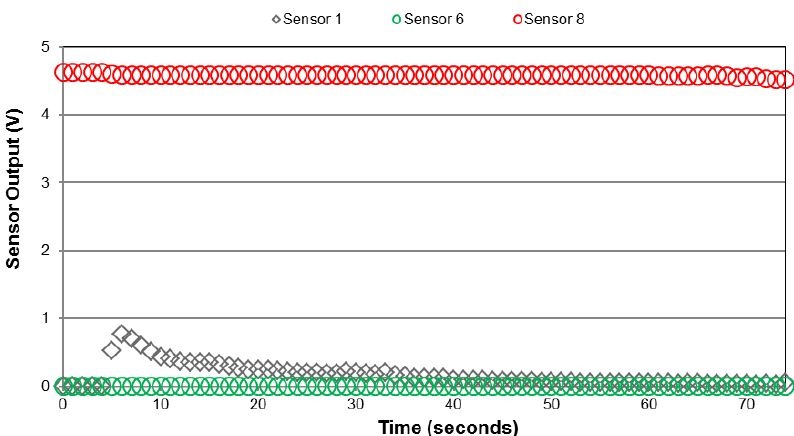
Figure 4. Sensor output voltage versus time from XR 8001 nozzle at 207 kPa (Fine droplet spectra classification).